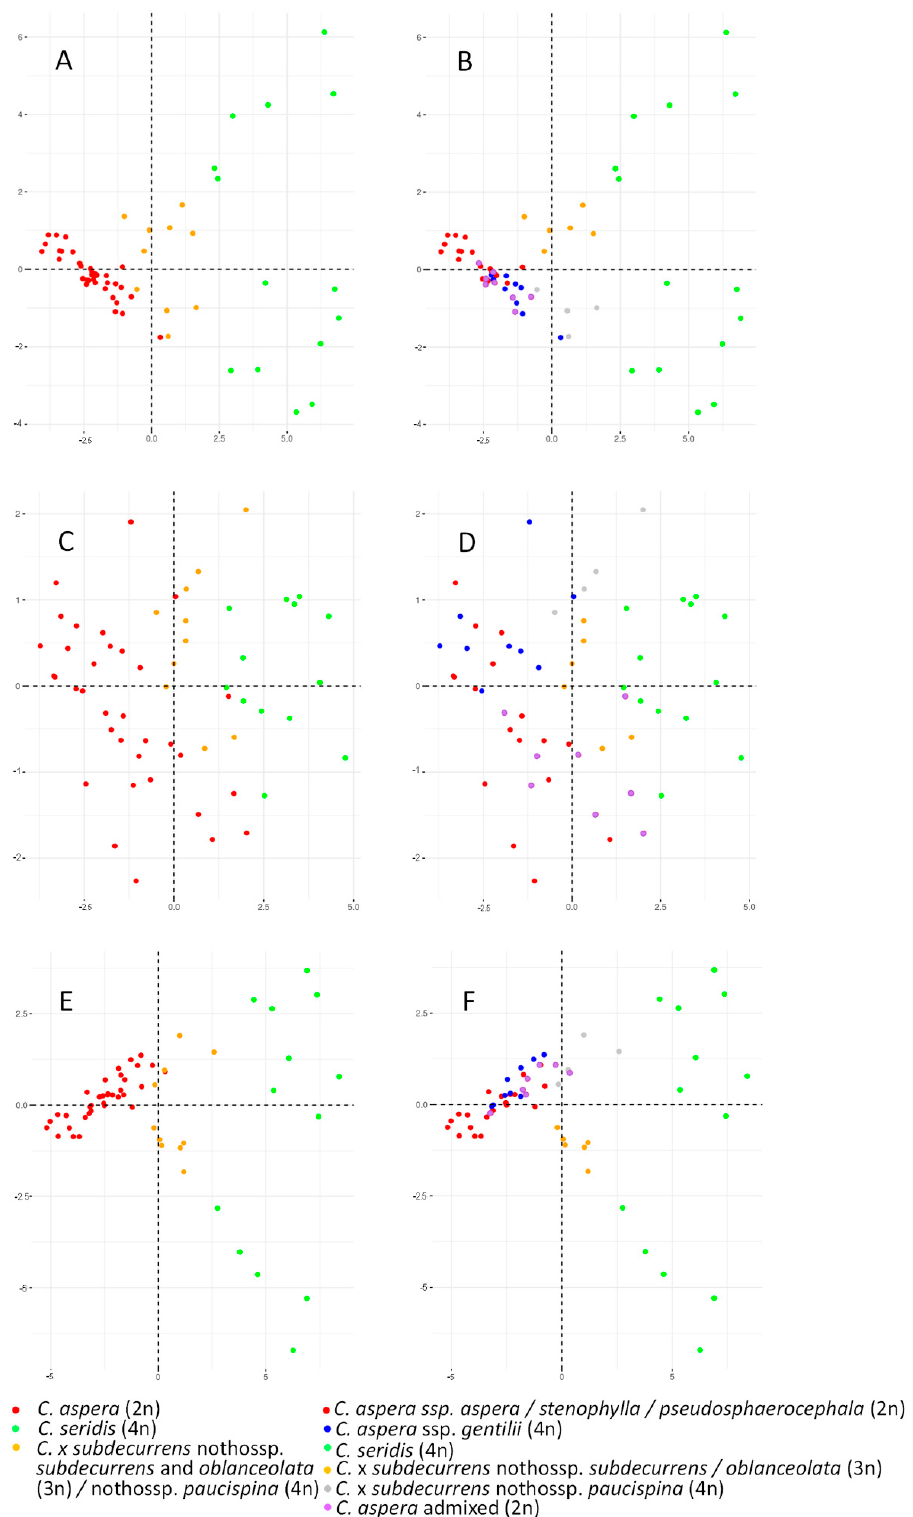
Figure 4. Two-dimensional plots of the principal component analyses based on the morphology of the Centaurea aspera , C. seridis and C. x subdecurrens hybrid individuals. STRUCTURE analysis was used for establishing genetic populations. ( A ) Vegetative characters at K = 2 and ( B ) at K = 3. ( C ) Reproductive characters at K = 2 and ( D ) at K = 3. ( E ) Vegetative and reproductive characters at K = 2 and ( F ) at K =